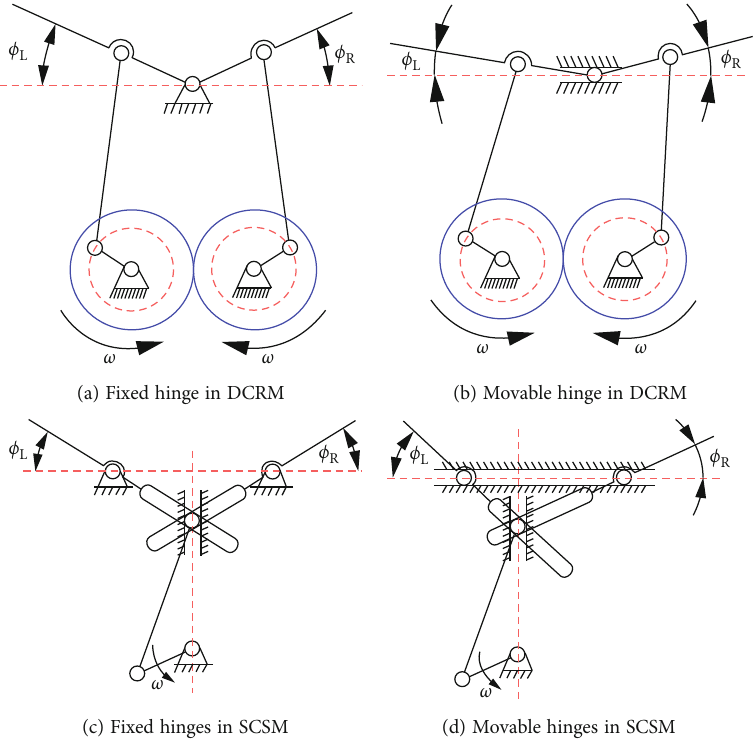
Figure 1: Diagram of hinge movement in DCRM and SCSM.